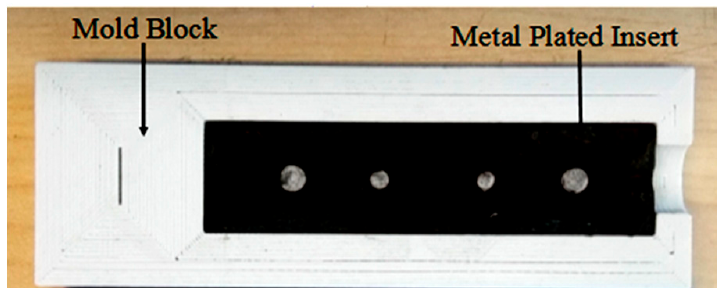
Figure 2. Metal plated ABS mold insert.